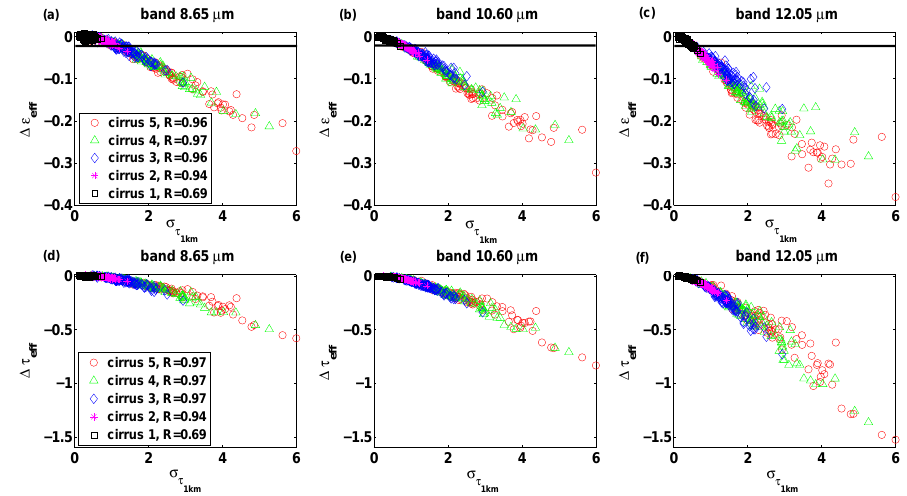
, for cirrus cases 1 ( τ c = 0 . 45 , ρ τ = 0 . 7), 2 1 km